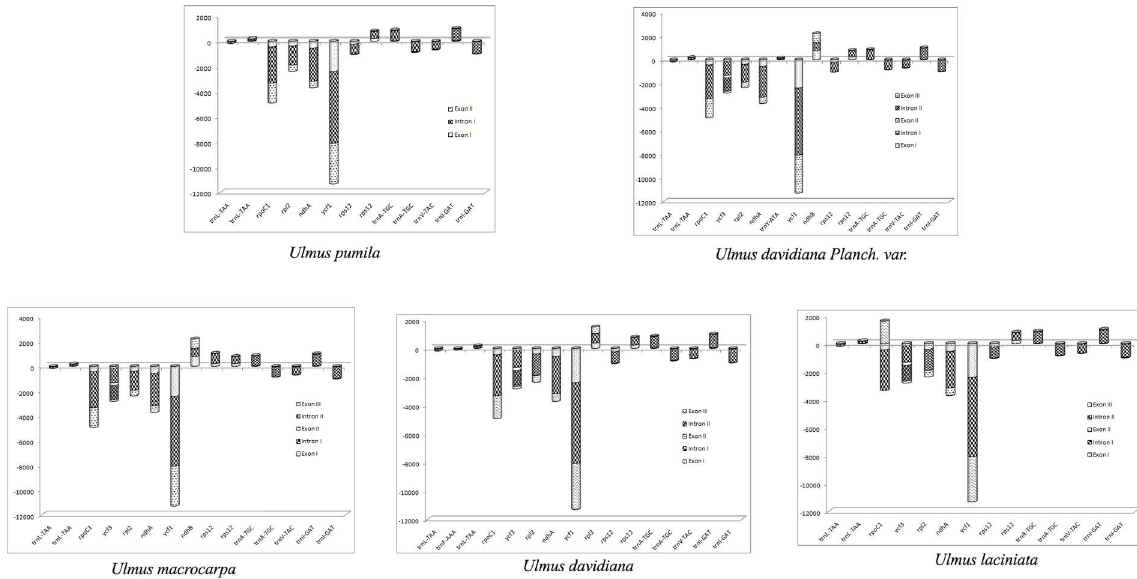
Fig 3. Intron length in the chloroplast genomes of five Ulmus